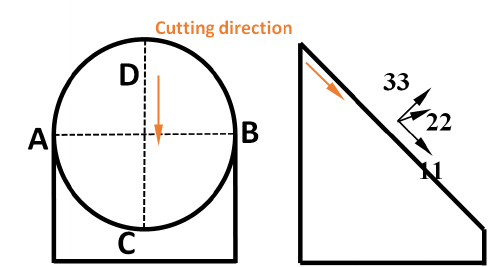
Figure 38. Specimen 2—line segments used for comparing stress levels on the planes of cut 2.